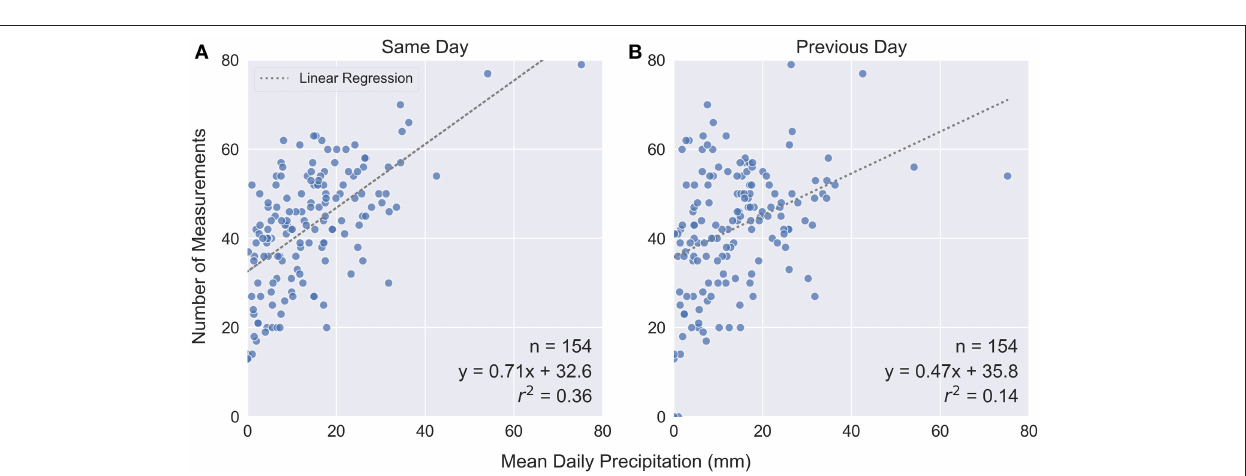
in this investigation) to be “negligible” (e.g., 0.2 mm day − 1